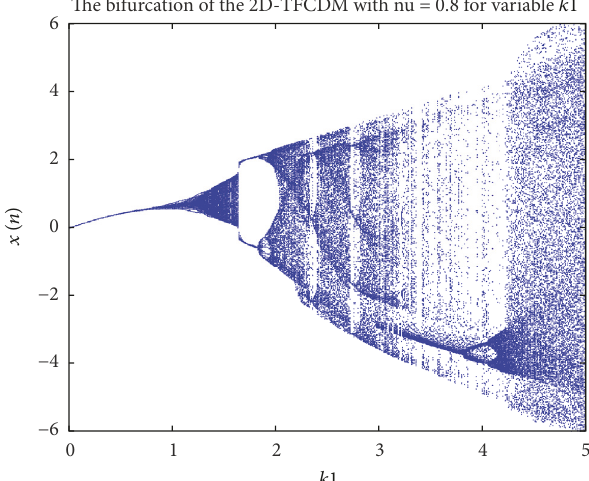
Figure 1: The bifurcation diagram of the 2D-TFCDM of variable 𝑘 1 for ] = 1 . Figure 2: The bifurcation diagram of the fractional 2D-TFCDM of variable 𝑘 1 for ] = 0.8